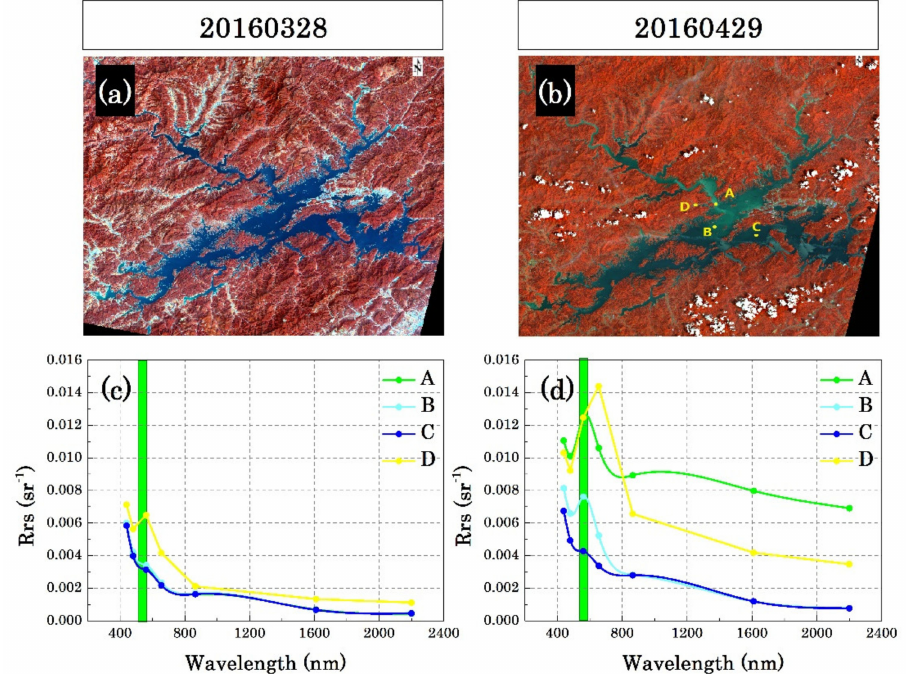
Figure 4. Remote sensing reflectance (Rrs) dynamics at typical stations in the Qiandao Lake. The left column shows the result on March 28 and the right column is the result on April 29. ( a , b ) are false-color composite images. ( c , d ) are Rrs spectral